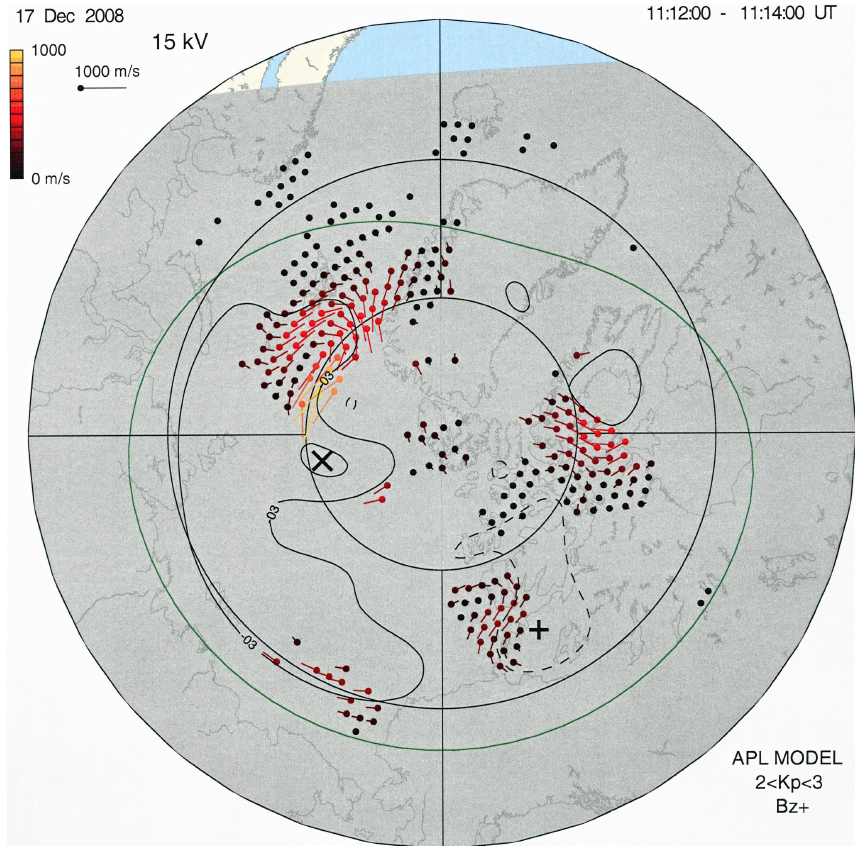
Fig. 9. SuperDARN spatial convection plot for 11:12–11:14UT, 17 December 2008 representing flow channel FC 2 of type NH-dusk/ B y < 0. The coordinate system is MLAT/MLT. The Sun is at the top and dusk is to the